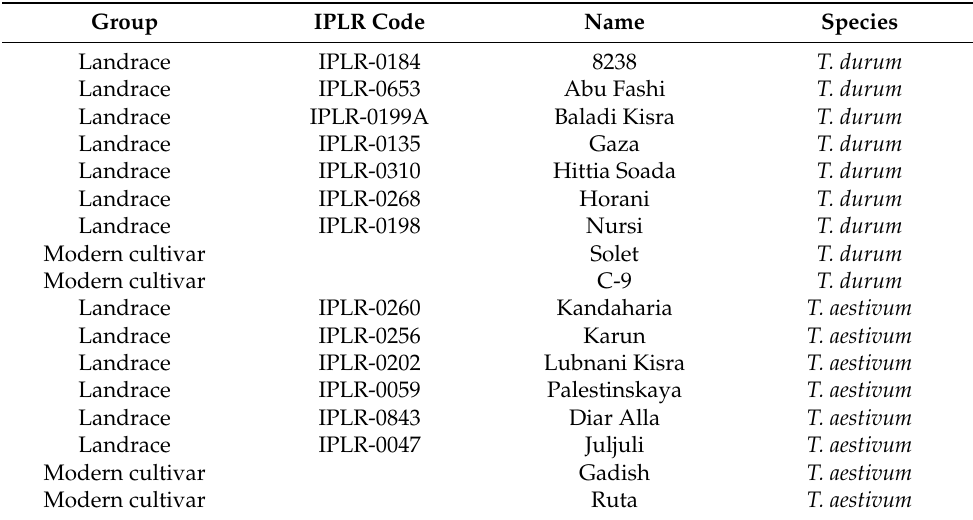
Table A1. Details of landraces and modern varieties included in the IPLR subset panel.